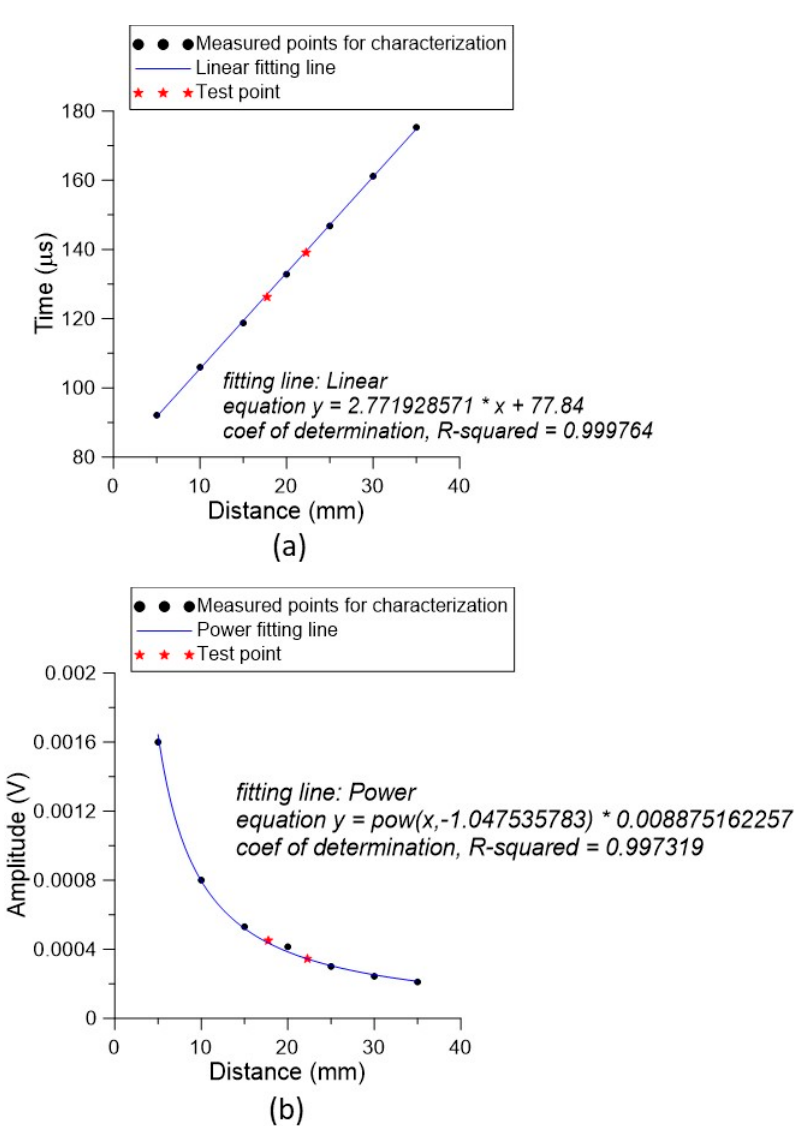
Figure 12. Characterized and tested results of the developed PMUT-microphone pair for range finding: ( a ) based on the time-of-flight principle and ( b ) based on the strength variation technique.